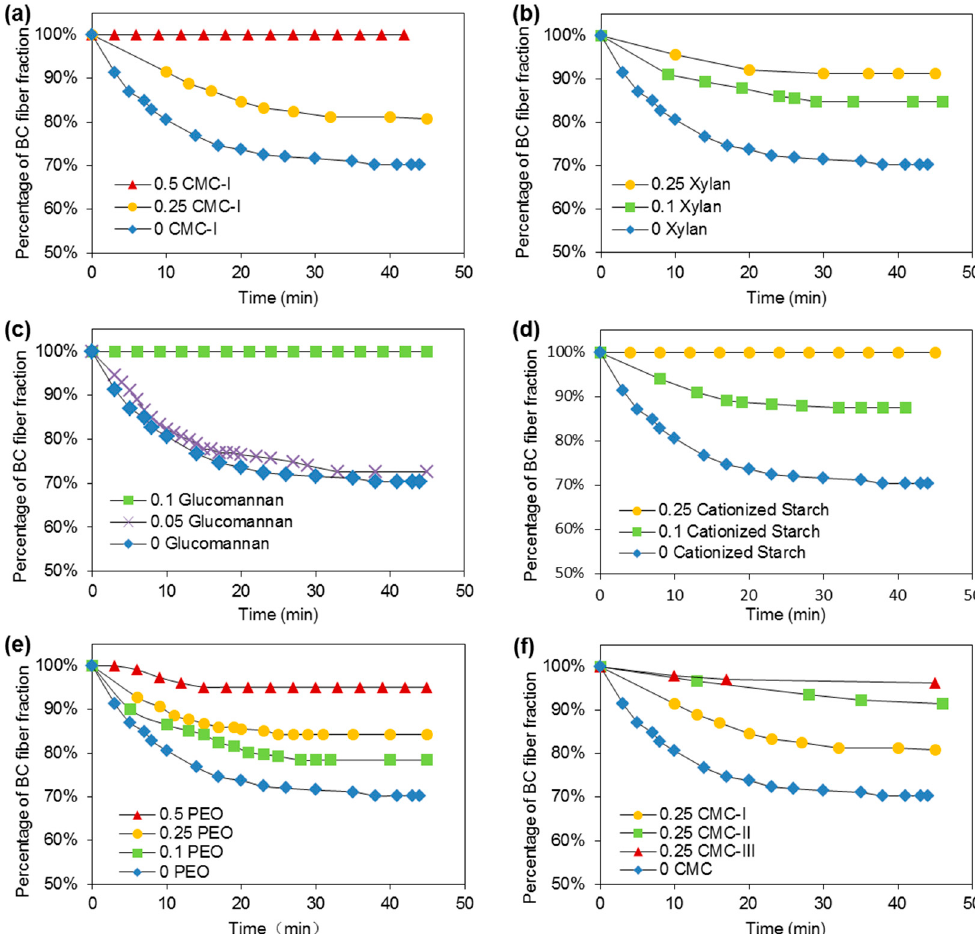
Figure 2. The changes of the percentage height of BC fiber fractions in the 250 mL-cylinder with time for BC fiber suspensions dispersed by ( a ) CMC-I, ( b ) xylan, ( c ) glucomannan, ( d ) cationized starch, ( e ) PEO, and ( f ) CMC. Table 1. Viscosity (mean ± STDEV) of different macromolecules at 0.15 g/L concentration and measured at 250 rpm rotational speed of the rotational viscometer.